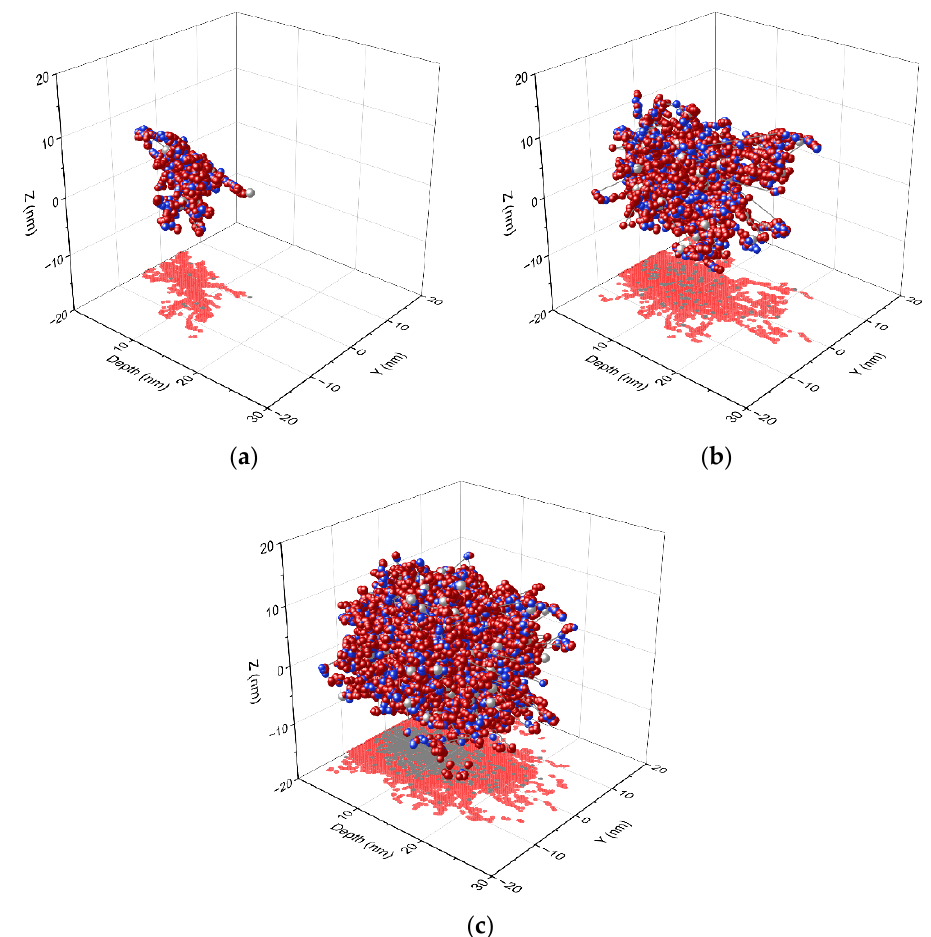
Figure 3. Ion and atom recoils for ( a ) 10, ( b ) 100, and ( c ) 1000 Cr ions. Blue balls are O atoms, red Cu atoms, and gray Cr ions; the projection: red are atoms O and Cu, and gray is Cr ions.